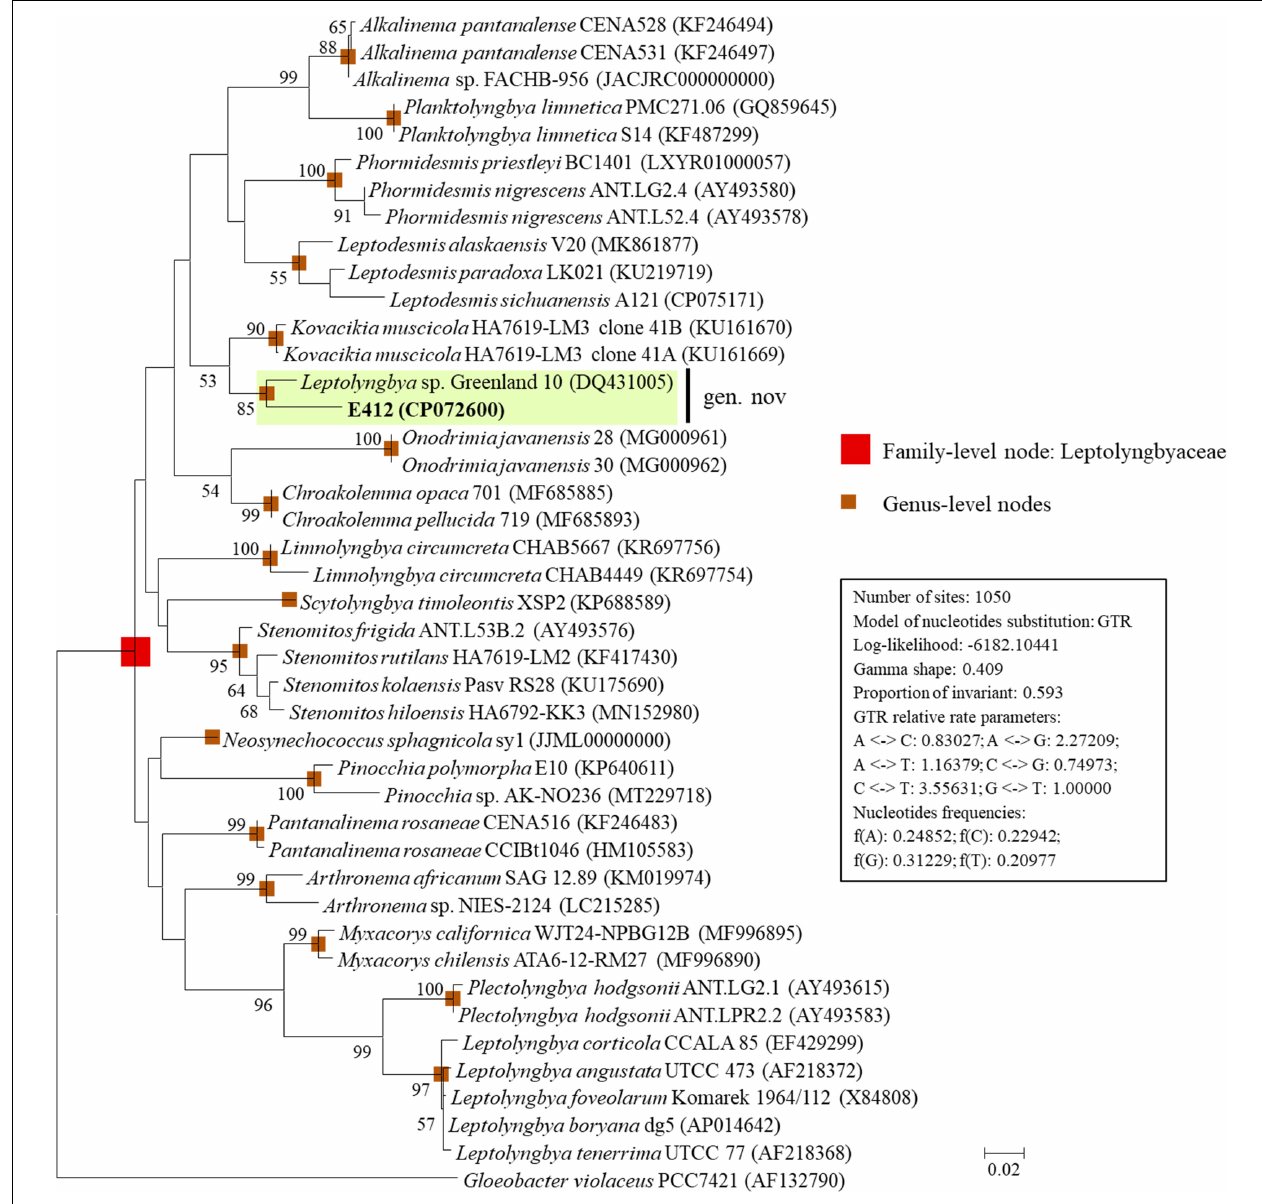
FIGURE 1 | ML phylogenetic tree of 16S rRNA gene sequences. Strain no. in bold represent the strains identified in this study. Only bootstrap values > 50% (1,000 non-parametric replications) are indicated at nodes. Scale bar = 2% substitutions per